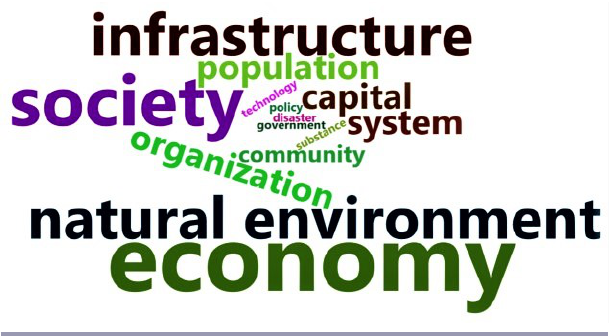
Fig. 2 . Most common elements in disaster resilience